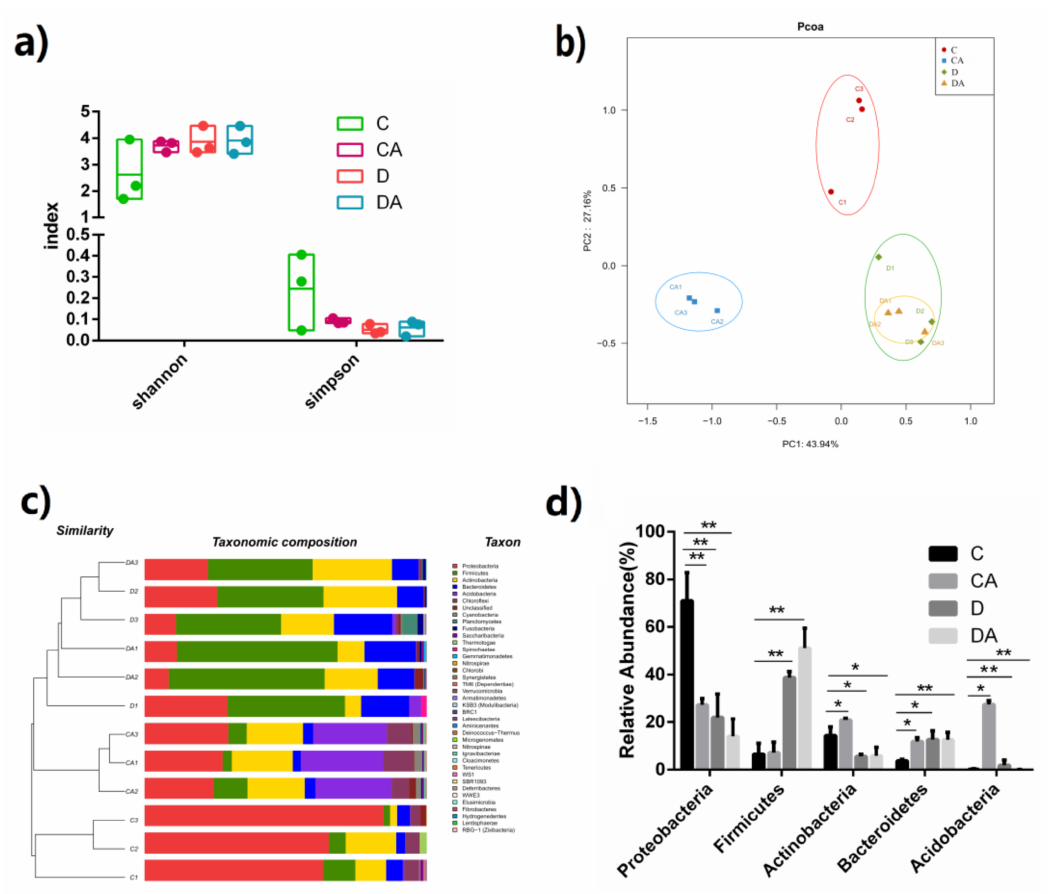
Figure 6. Effects of BANCs on the DSS-induced female D. melanogaster intestinal microbiota. C, CA, D, and DA represent the blank control group, BANC control group, inflamed group, and BANCs + inflamed group, respectively. ( a ) Effect of BANCs on the α -diversity (Shannon and Simpson index) of the midgut microbiota of DSS-exposed D. melanogaster . The p value of all the groups was obtained by the Kruskal–Wallis test. ( b ) Effect of BANCs on the β -diversity of the midgut microbiota of DSS-exposed D. melanogaster and PCoA based on weighted UniFrac distance. ( c ) Bacterial taxonomic profiling of the four groups at the phylum level ( n = 3). ( d ) Relative abundances of five intestinal microorganisms in DSS-induced D. melanogaster at the phylum level. The results are presented as the means ± SEMs ( n = 3); statistical comparisons were performed with t tests. Statistical significance: * p < 0.05, ** p <